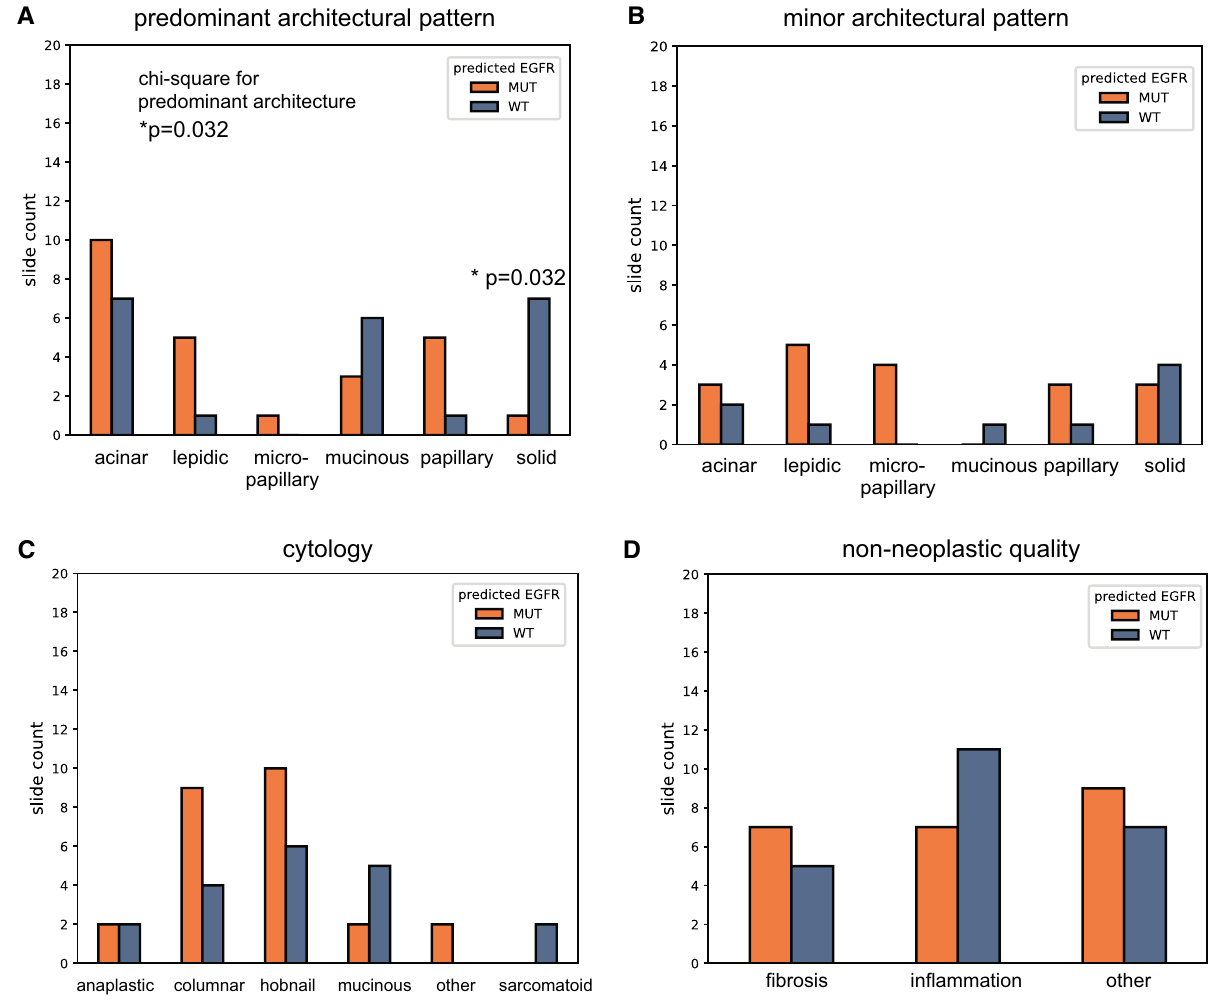
Figure 4. Overall bag characteristics of high-attention patches for categorical variables for 49 pathologist reviewed bags. (a) Predominant architectural pattern of high-attention patches, determined by patch mode, by predicted status. p -value from a Chi-squared test of the overall distribution. (b) Minor architectural pattern of high-attention patches. (c) Cytology for high-attention patches, determined by patch mode. (d) Non-neoplastic qualities present in high-attention patches, as determined by patch